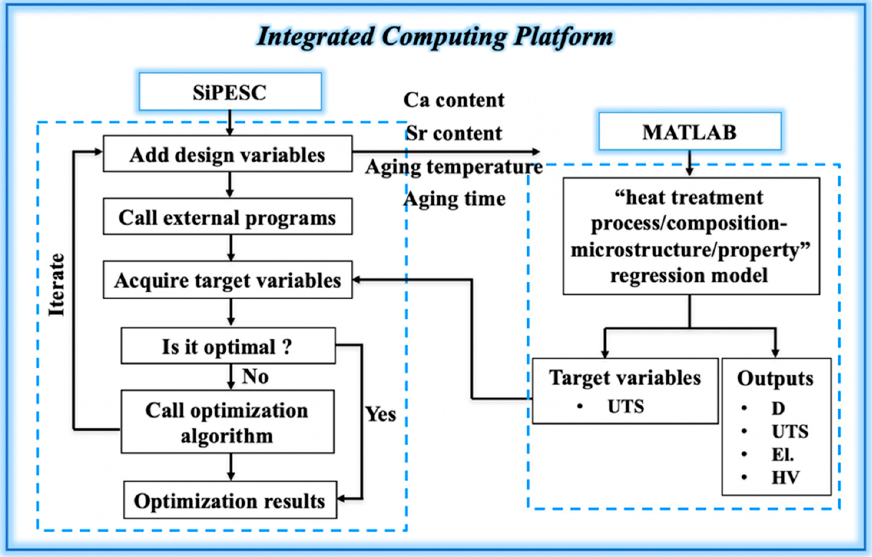
Figure 6. The architecture diagram showing “heat treatment process/composition-microstructure/property” integrated computing system.